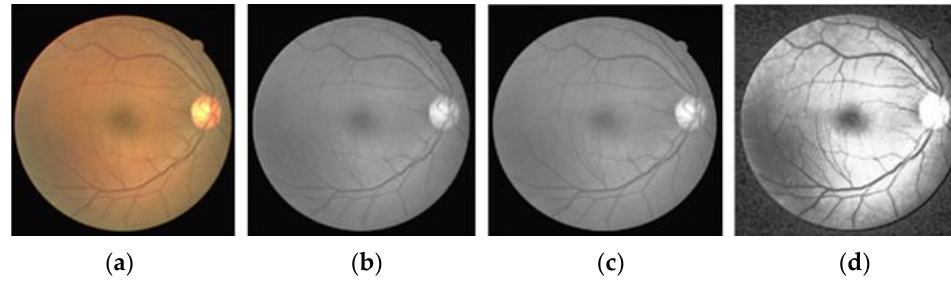
Figure 2. Main preprocessing step performed in the context of our methodology. ( a ) Original image; ( b ) Image after grayscale conversion; ( c ) Image after Erosion Morphological operation; ( d ) Image after Histogram Equalization operation.